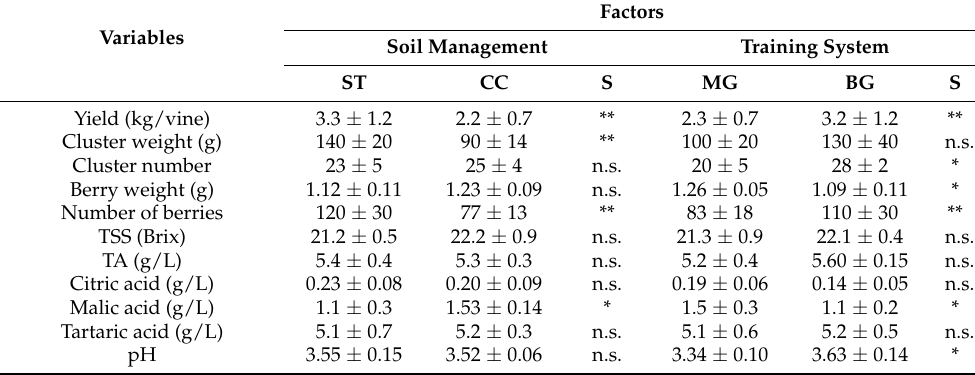
Table 1. Effects of soil management and training systems on yield components and fruit